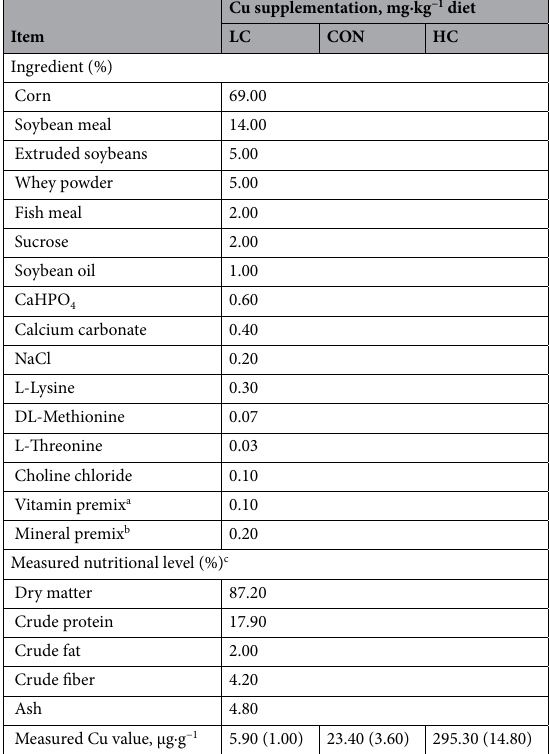
as needed. Wet creep feed was removed, dried, and weighed, and feeders were refilled approximately every 8 h. Creep feed consumption was recorded daily. Individual pigs were weighed at d 14, 28, and 40 d post farrowing. Piglet BW and creep feed consumption were used to calculate ADG and ADFI. The diarrhea rate of piglets was recorded daily and calculated as follows: Diarrhea rate (%) = the number of pigs with diarrhea × diarrhea days/ (the total number of pigs × experiment days) × 100%, in which the “number of pigs with diarrhea” was defined as the number of piglets with diarrhea was observed each day 46 . Three litters were chosen within each treatment at 40 d. Feces, blood, and hair samples were collected from four piglets/litter, selected based on average BW (half male and female). Hair samples of the head, back, and but- tocks of the piglets were collected and mixed; Blood samples were collected from the anterior vena cava of piglets and stored in glass tubes with no anticoagulant and were allowed to clot at 4 °C before the serum harvest by centrifugation (15 min at 3, 500 g); serum, hair and fecal samples were stored at − 80 °C for subsequent analysis 15 . Ionomics analysis. Thirteen elements, including macroelements (Ca, Mg, Na, K, P), microelements (Fe, Cu, Mn, Zn, Cr), and toxic-elements (Pb, Al, Ni) were measured in hair, serum, and feces using inductively coupled plasma optical emission spectrometry (ICP-OES) (PerkinElmer, USA). Hair (200 μg), serum (1 mL), and dried feces (500 μg) were placed in a tube with 10 mL of a mixture of nitric acid (guaranteed reagent, GR) and perchloric acid (GR) (3:1 v/v). After digestion overnight, tubes were heated from 100 °C to 240 °C over approximately 3 h, and the resulting digests were brought to constant volume with double distilled-deionized water 15,47 . The standard liquid of Ca, Mg, Na, K, and P (1000 µg·mL −1 ) were mixed to prepare 5 mL mixed stand-